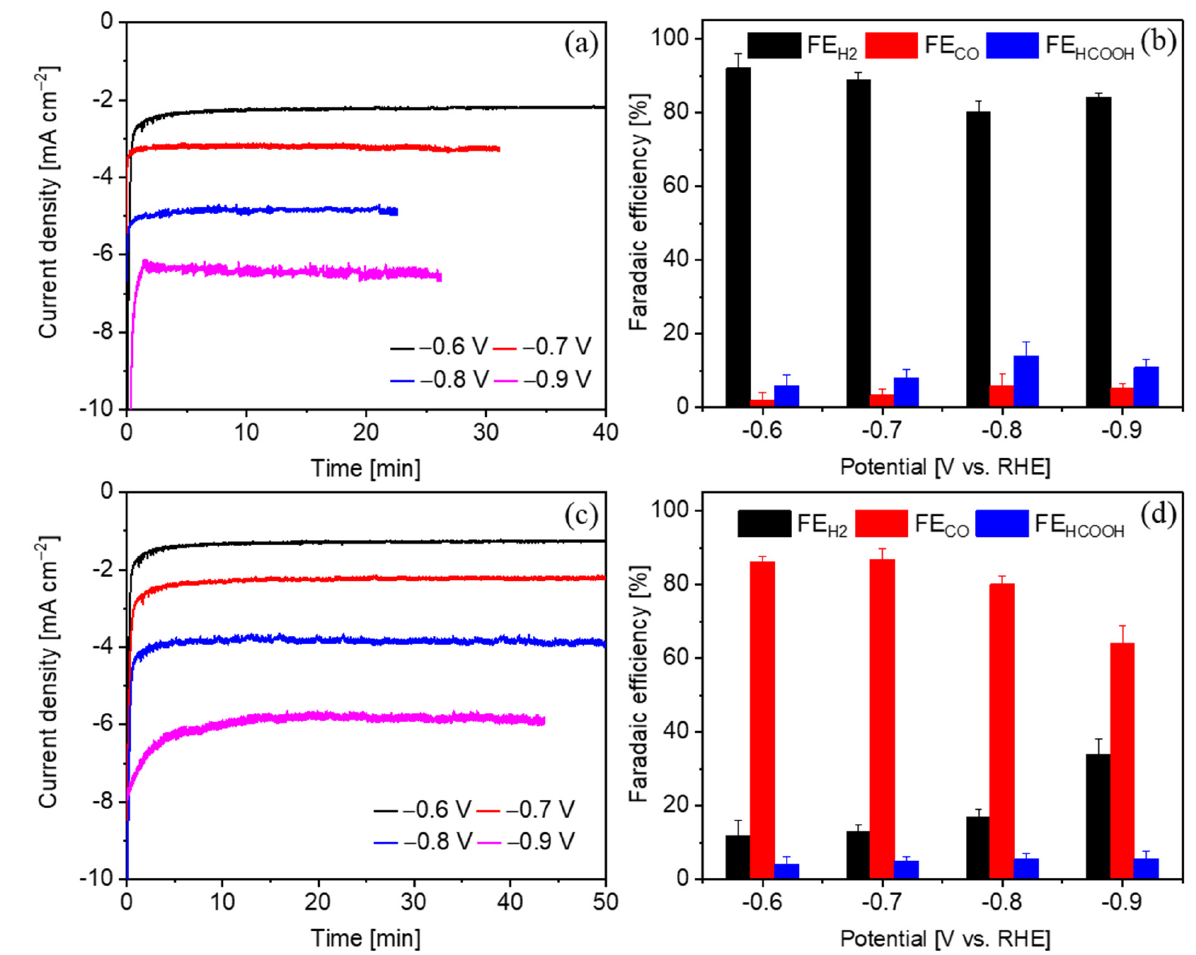
Figure 4. CA measurements and product analyses in a CO 2 -saturated 0.1 M KHCO 3 aqueous solution in a batch cell. ( a ) i-t curves at various potentials on Cu 2 O electrode and ( b ) the corresponding product analyses, ( c ) i-t curves at various potentials on Sn-Cu 2 O electrode and ( d ) the corresponding product analyses.